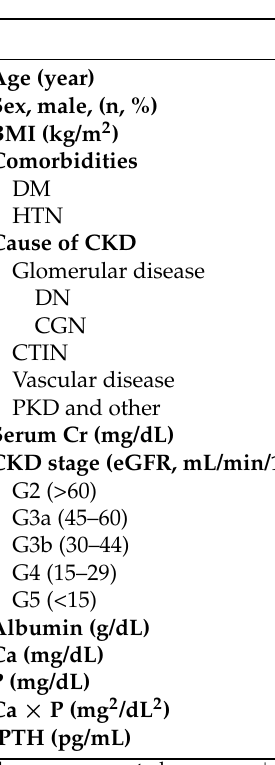
Table 1. Demographics and laboratory findings of study